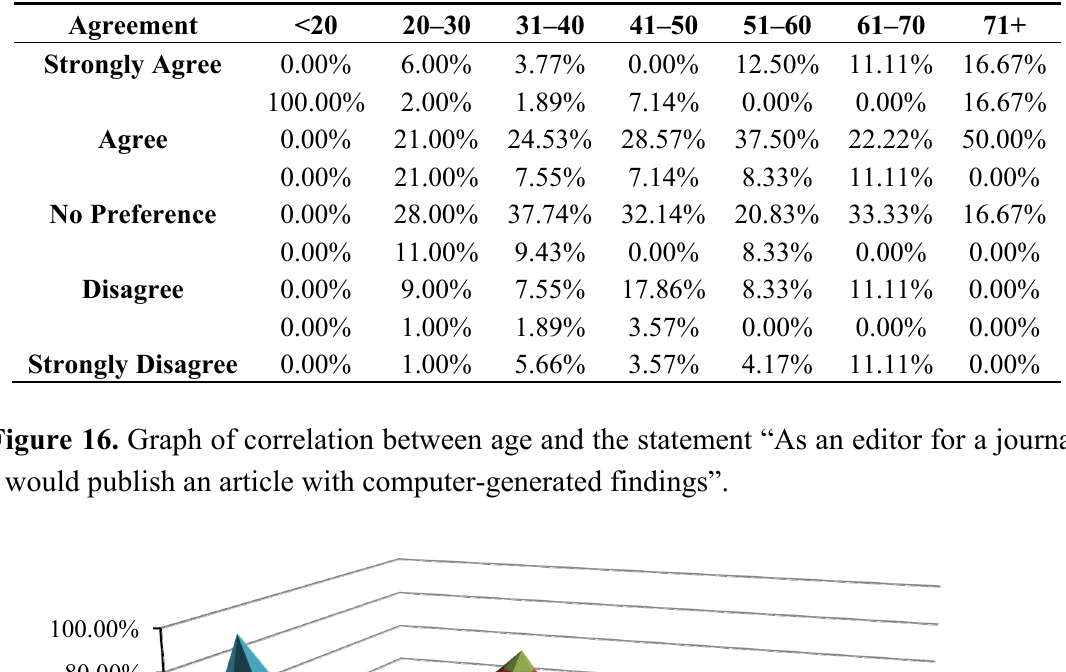
Table 15. Correlation between age and the statement “As an editor for a journal, I would publish an article with computer-generated findings”.